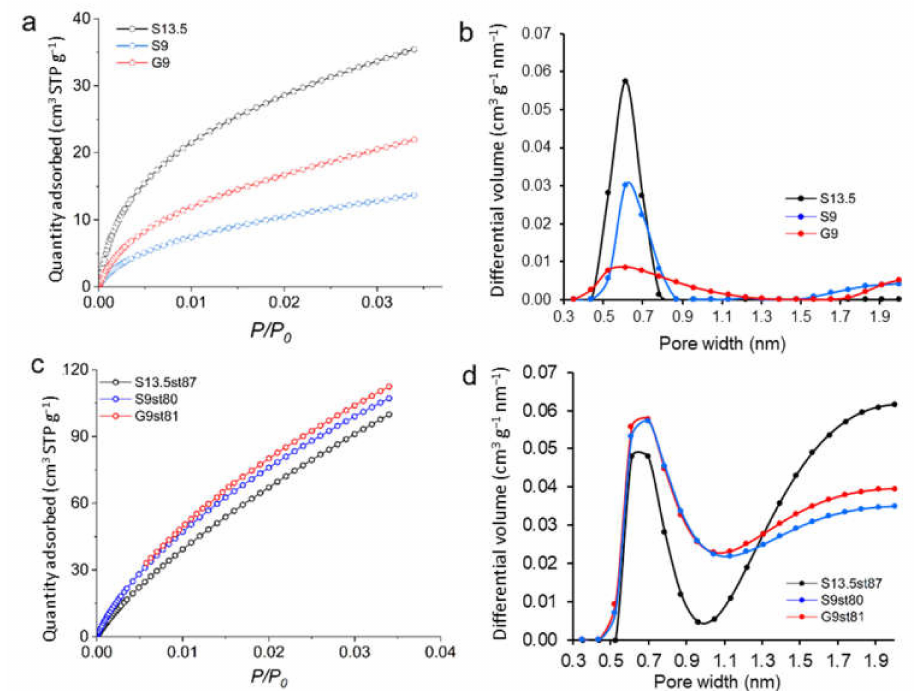
Figure 4. CO 2 adsorption isotherms ( a , c ) and pore size distributions ( b , d ) of acid-chars ( a , b ) and activated carbons ( c , d ) at 0 ◦